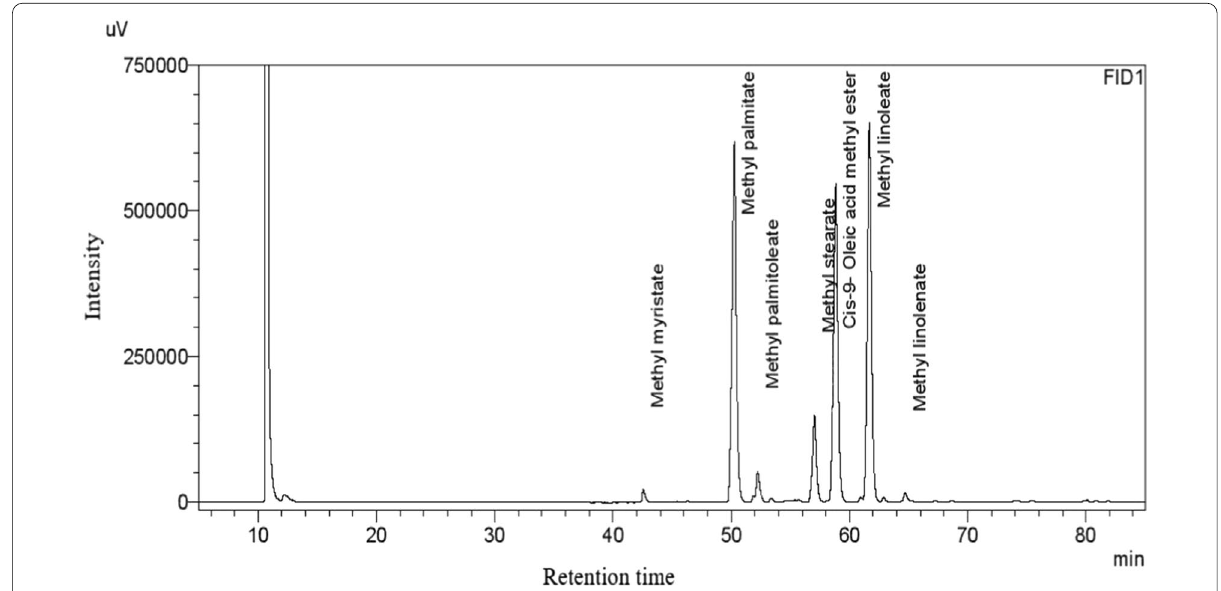
Fig. 5 Peak graphs denoting the fatty acids determined using the GC-FID